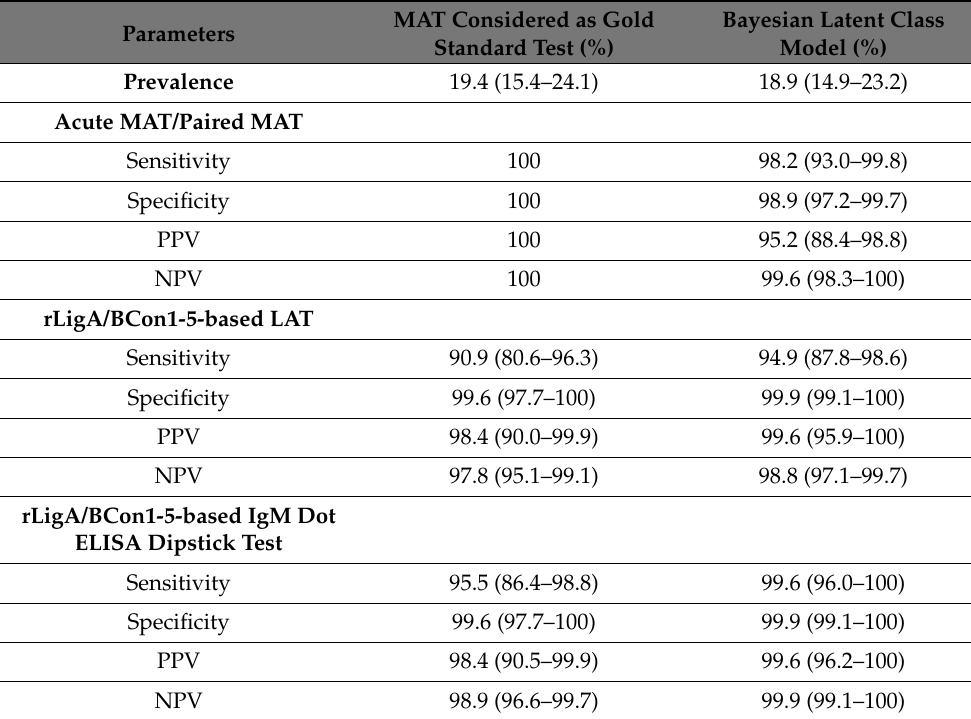
Table 3. Comparison of the diagnostic accuracies of acute/paired MAT (final MAT) with IgM dot ELISA dipstick test and latex agglutination test by considering MAT as reference/gold standard as well as imperfect test as in